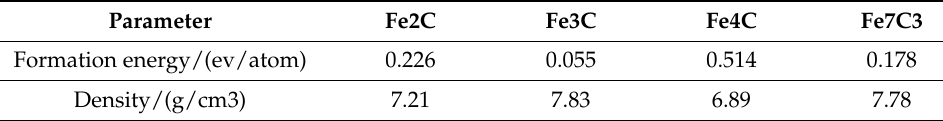
Table 6. Formation energy and density of various carbides.